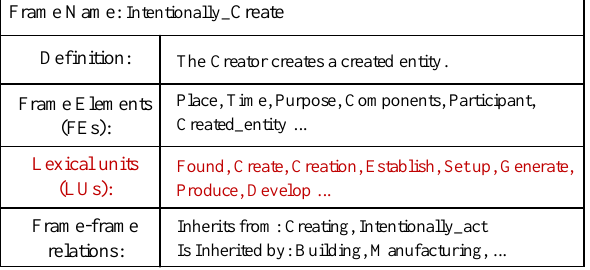
Figure 1. Semantic frame of the relation founder . The relation indicators are extracted from the Lexical